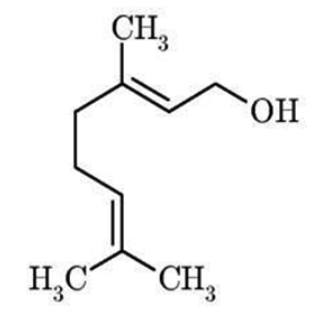
Fig. 1. Structure of geraniol, a monoterpenoid alcohol